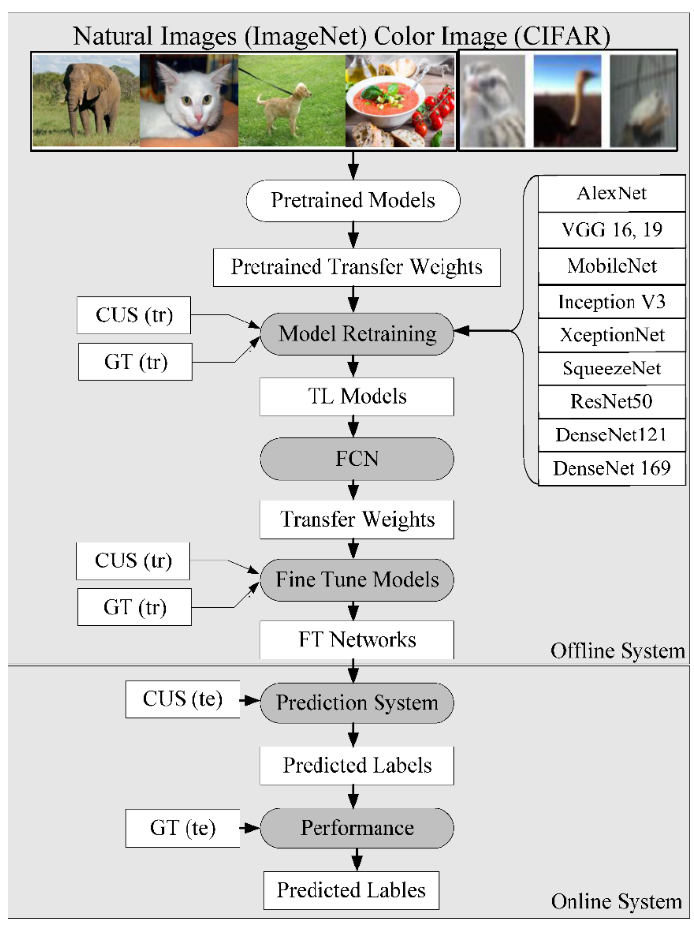
Figure 20. Transfer learning model to predict vascular disease [44].